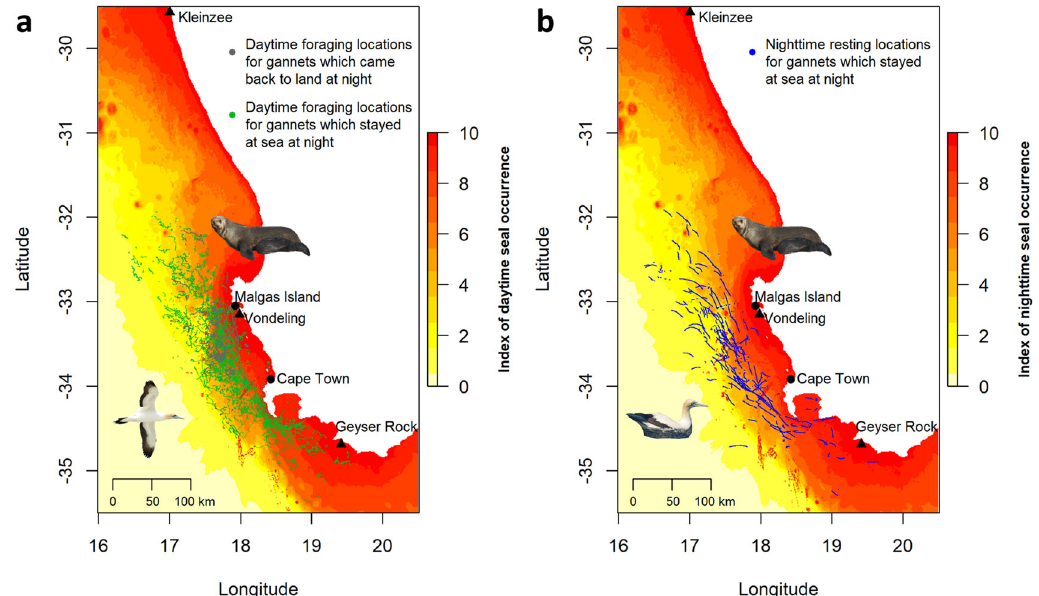
Fig. 1 Seascape of fear induced by Cape fur seals for Cape gannets. a Daytime seascape of fear (yellow to red index of seal occurrence) and daytime foraging locations for gannets returning to the colony at night (gray dots) or resting at sea all night (green dots). b Nighttime seascape of fear (yellow to red index of seal occurrence) and gannet nighttime at-sea resting locations (blue dots). Seals ( n = 25 individuals) were Argos-tracked from three colonies (black triangles) and gannets ( n = 197 individuals) were GPS-tracked from Malgas Island (black